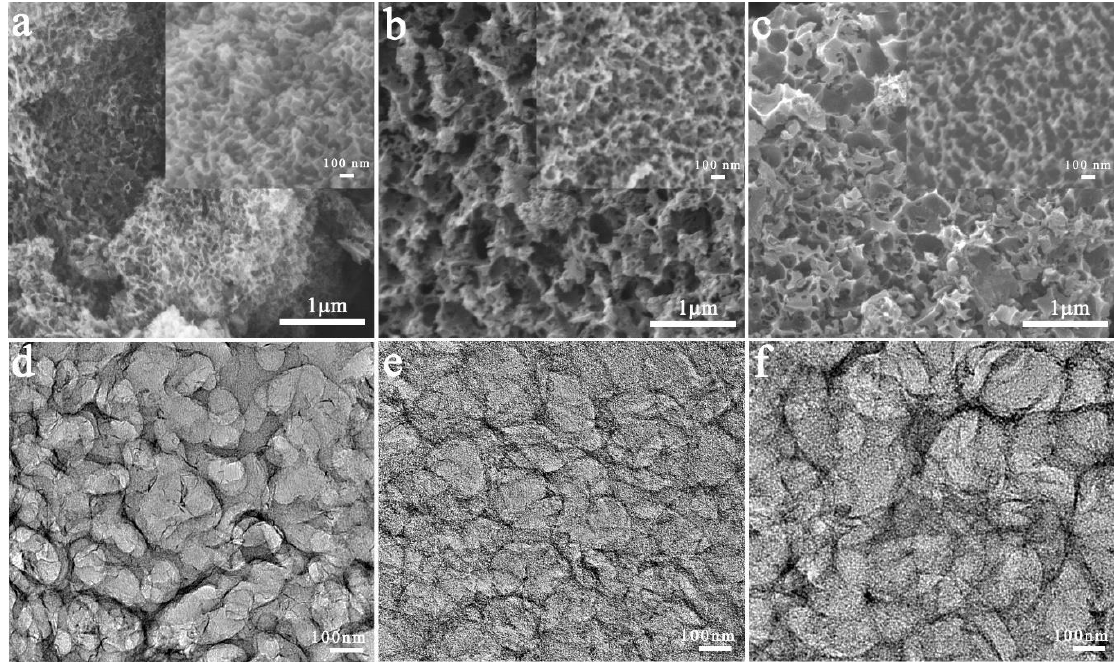
Figure 1. Field emission scanning electron microscopy (FESEM) image and transmission electron microscopy (TEM) image of cellulose-derived porous carbon (CPC)-6 ( a , d ), CPC-9 ( b , e ), and the CPC-12 ( c , f ).